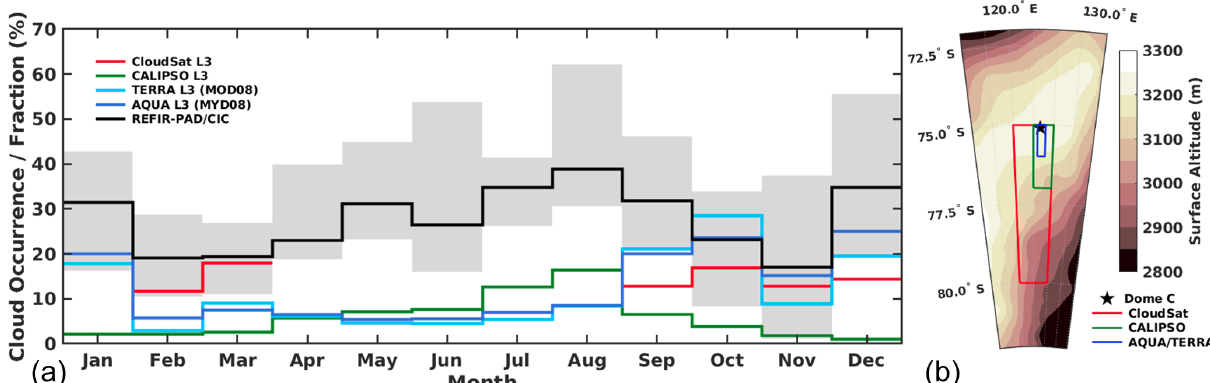
Figure 10. (a) Percentage fraction of CIC monthly mean cloud occurrence (in black) compared with the CloudSat L3 product (red line), CALIPSO L3 product (green line), MODIS TERRA L3 product – MOD08 (light-blue line), and MODIS AQUA L3 product – MYD08 (blue line). The shaded gray area indicates the minimum and maximum CIC monthly values in the interval 2012–2015. (b) Location of the Dome Concordia base and extension of the grid sector for CloudSat, CALIPSO, and AQUA/TERRA MODIS L3 data. Surface elevation above mean sea level is also